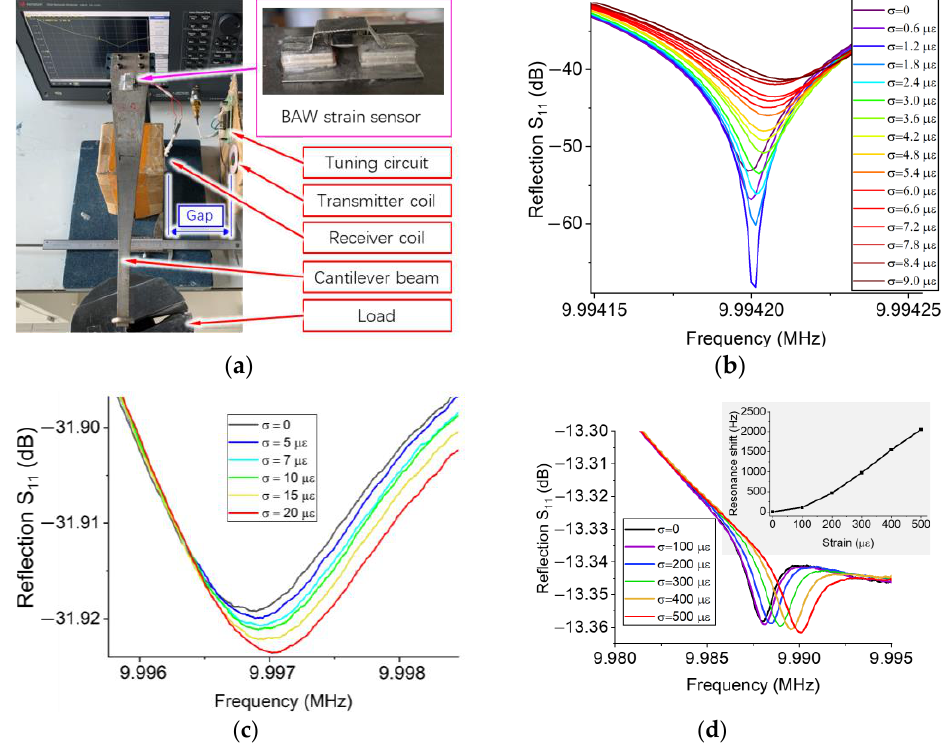
Figure 9. The design and demonstration of a prototype BAW passive wireless strain sensor. All signals are the average of five repeated measurements. ( a ) Experimental setup. ( b ) Sensor signals vs. strain at the optimal position. ( c ) Sensor signal vs. strain when gap was 8 cm. ( d ) The effect of strain on the sensor signal when the gap between coils was 10 cm.